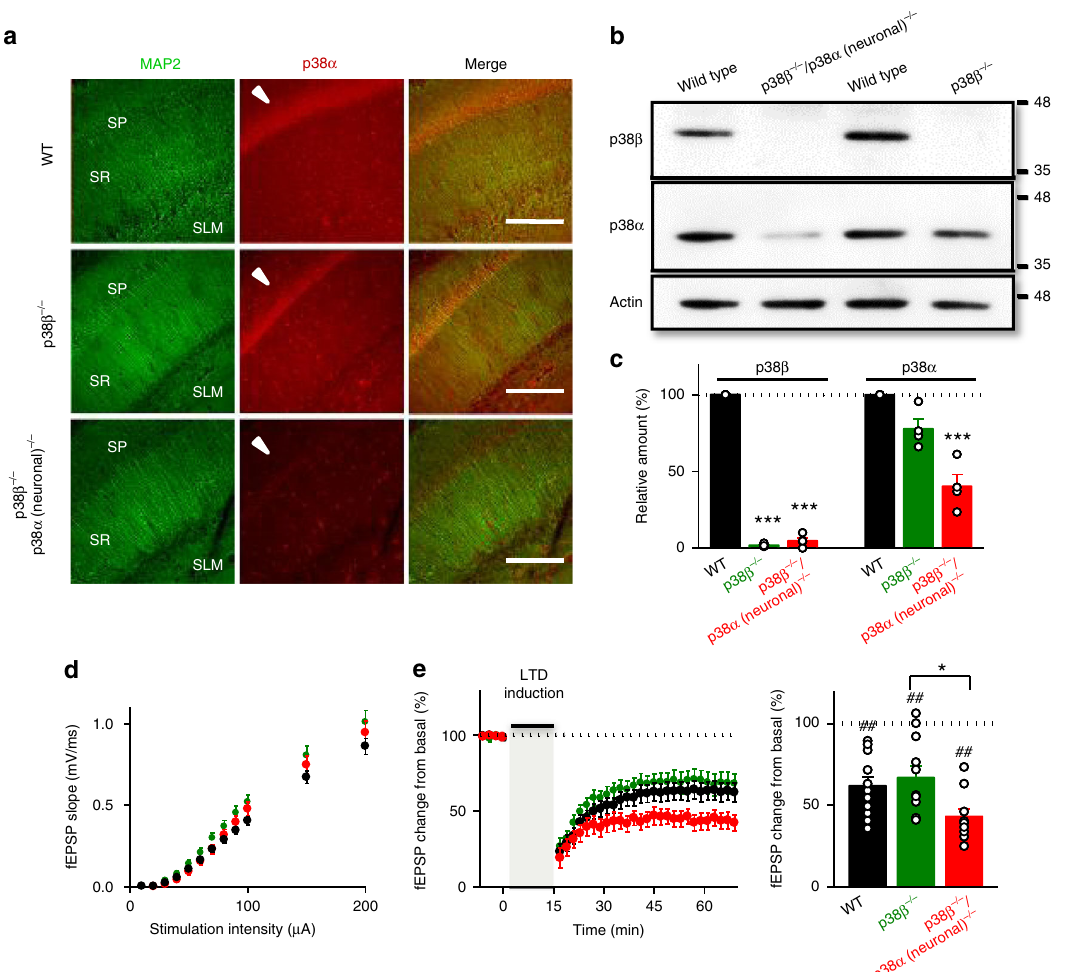
Fig. 6 Neuronal p38 α and p38 β MAPK are not necessary for NMDAR-dependent LTD. a Immunohistochemistry of hippocampal sections from WT, p38 β − / − , and p38 β − / − /p38 α (neuronal) − / − animals with anti-MAP2 antibody (green) and anti-p38 α antibody (red). SP: stratum pyramidale (indicated with an arrowhead in middle panels). SR: stratum radiatum. SLM: stratum lacunosum moleculare . Scale bars, 200 μ m. b Western blot analysis of p38 α and p38 β protein levels from WT, p38 β − / − , and p38 β − / − /p38 α (neuronal) − / − hippocampus. Actin served as a loading control. c Relative amount in percentage of p38 β and p38 α from WT (black bars, n = 6), p38 β − / − (green bars, n = 4), and p38 β − / − / p38 α (neuronal) − / − (red bars, n = 4) from western blots as the one shown in b . Kruskal – Wallis test followed by Dunn ’ s test (*** P < 0.001). d Input – output curves presenting fEPSP slope from acute hippocampal slices in response to increasing stimulus strength ( n > 39 slices from n > 7 mice). No differences were found by two-way ANOVA ( F (2, 240); P = 0.73). e (Left) Time course of relative changes in fEPSP slope before and after LFS in acute hippocampal slices from WT (black, n = 11 from 7 mice), p38 β − / − /p38 α neuronal) − / − (red, n = 9 slices from 7 mice) and p38 β − / − (green, n = 11 from 7 mice) knockout mice. (Right) Summary of results from the end of the time courses shown on the left. Differences between groups were determined by Kruskal – Wallis test followed by Dunn ’ s test (* P <